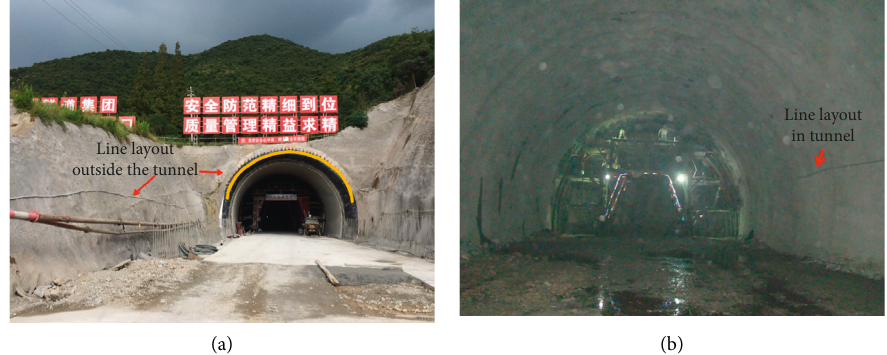
Figure 7: Layout of the field monitoring system: (a) line layout outside the tunnel; (b) line layout in the tunnel.